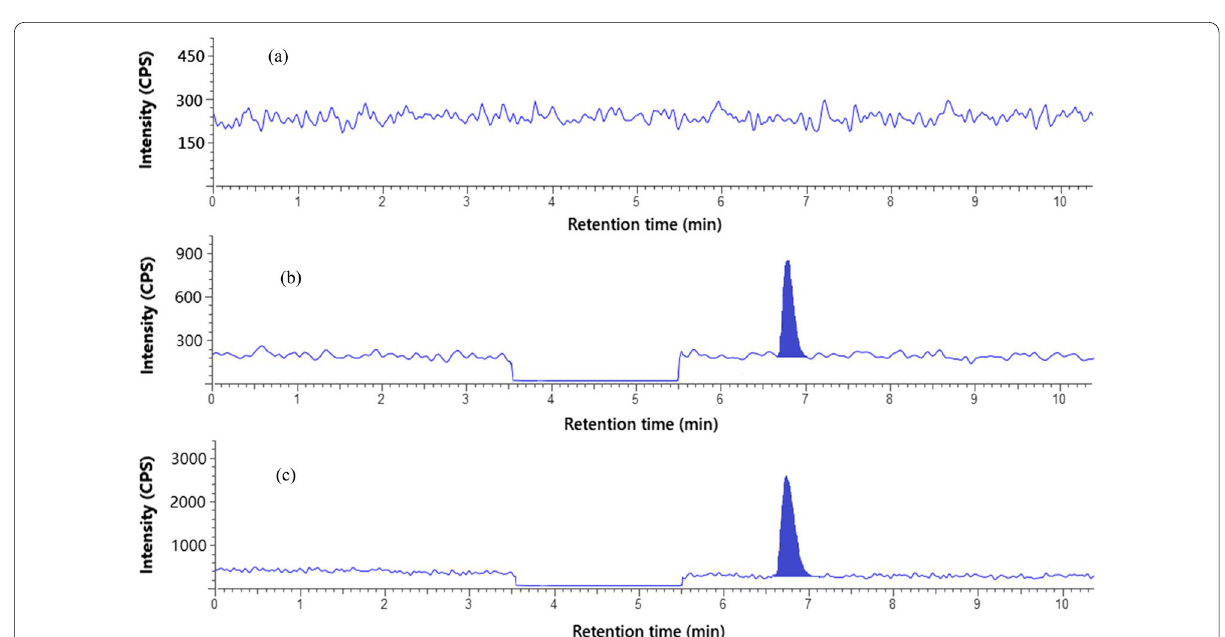
Fig. 3 Overlay MRM signal of a Blank, b LOD solution and c LOQ